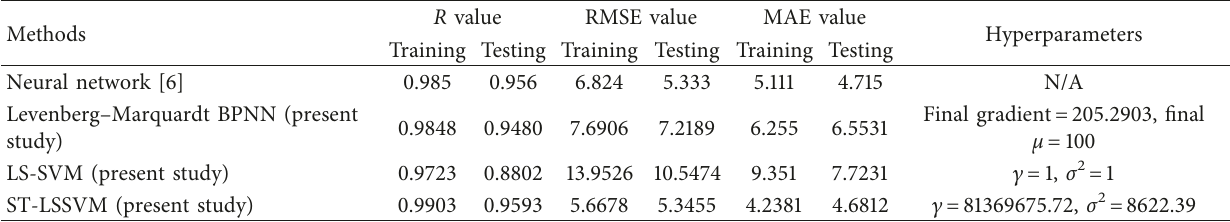
Table 3: Comparative results of the predictive methods.